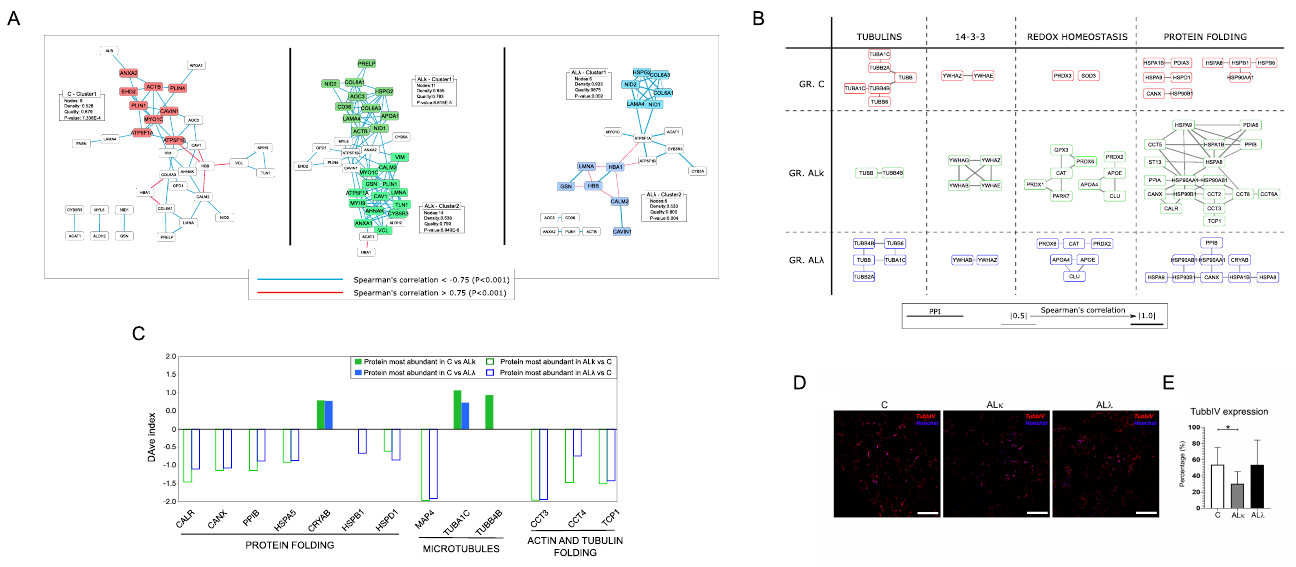
Figure 4. PPI functional modules differentially correlated. ( A ) Clusters of proteins highly correlated in C, AL κ and AL λ . ( B ) Correlation changes among subunits/proteins physically and functionally interacting in complexes and biological processes. ( C ) DAve index of DAPs involved in protein folding and microtubule-related processes. A positive DAve index indicates that protein most abundant in C, whereas negative DAve index indicates that protein most abundant in AL κ and AL λ . ( D ) Representative immunofluorescence images of sub-cutaneous adipose tissue from control subjects ( C ) and patients affected by AL amyloidosis (AL κ and AL λ ) stained against beta Tubulin IV (TUBBIV, red). Nuclei were detected with Hoechst (blue). Scale bars represent 150 µ m. ( E ) The graph highlights the quantification of TUBBIV in the immunostained samples; * p ≤